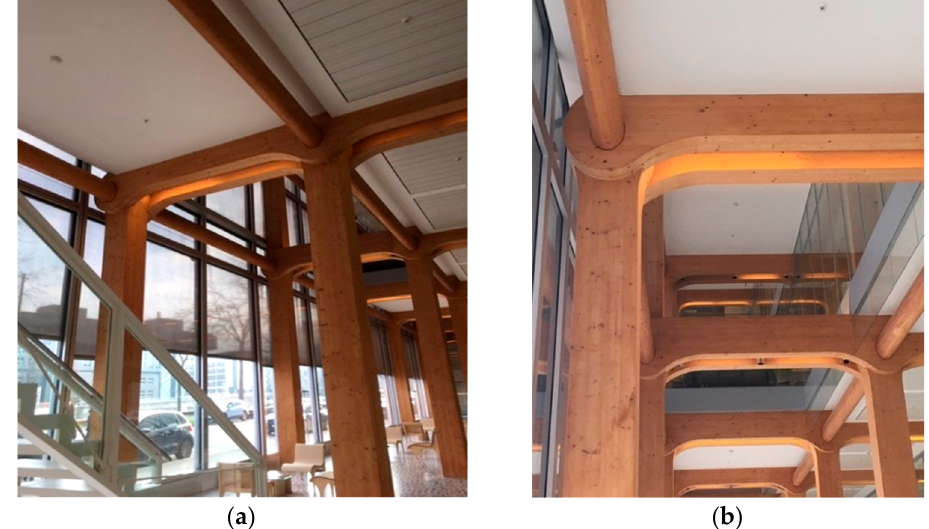
Figure 9. ( a , b ) Zurich, Tamedia Office Building ; architect: Shigeru Ban; details, photo: Joanna Arlet.